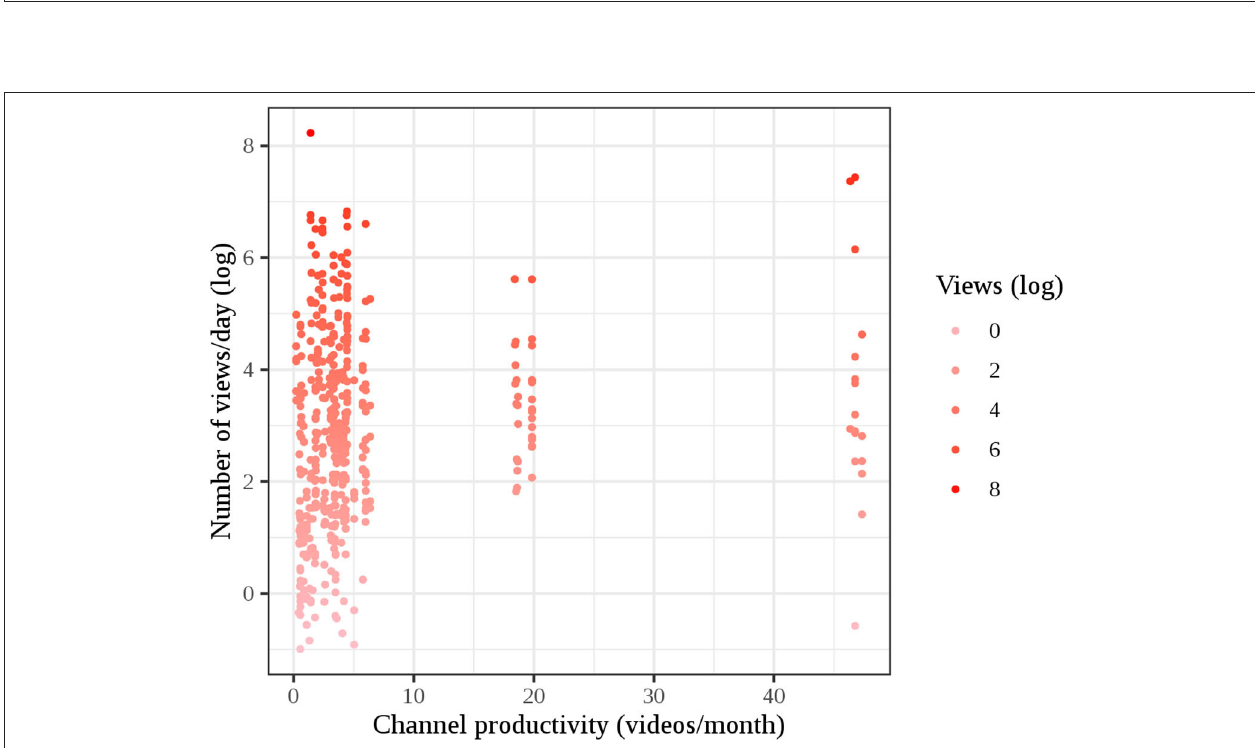
FIGURE 8 | Number of views per day (log) x channel productivity.